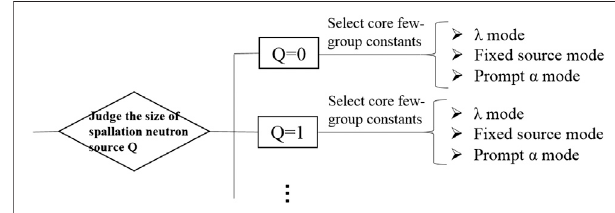
FIGURE 2 | Schematic of self-adapting multi-mode core few-group constants.